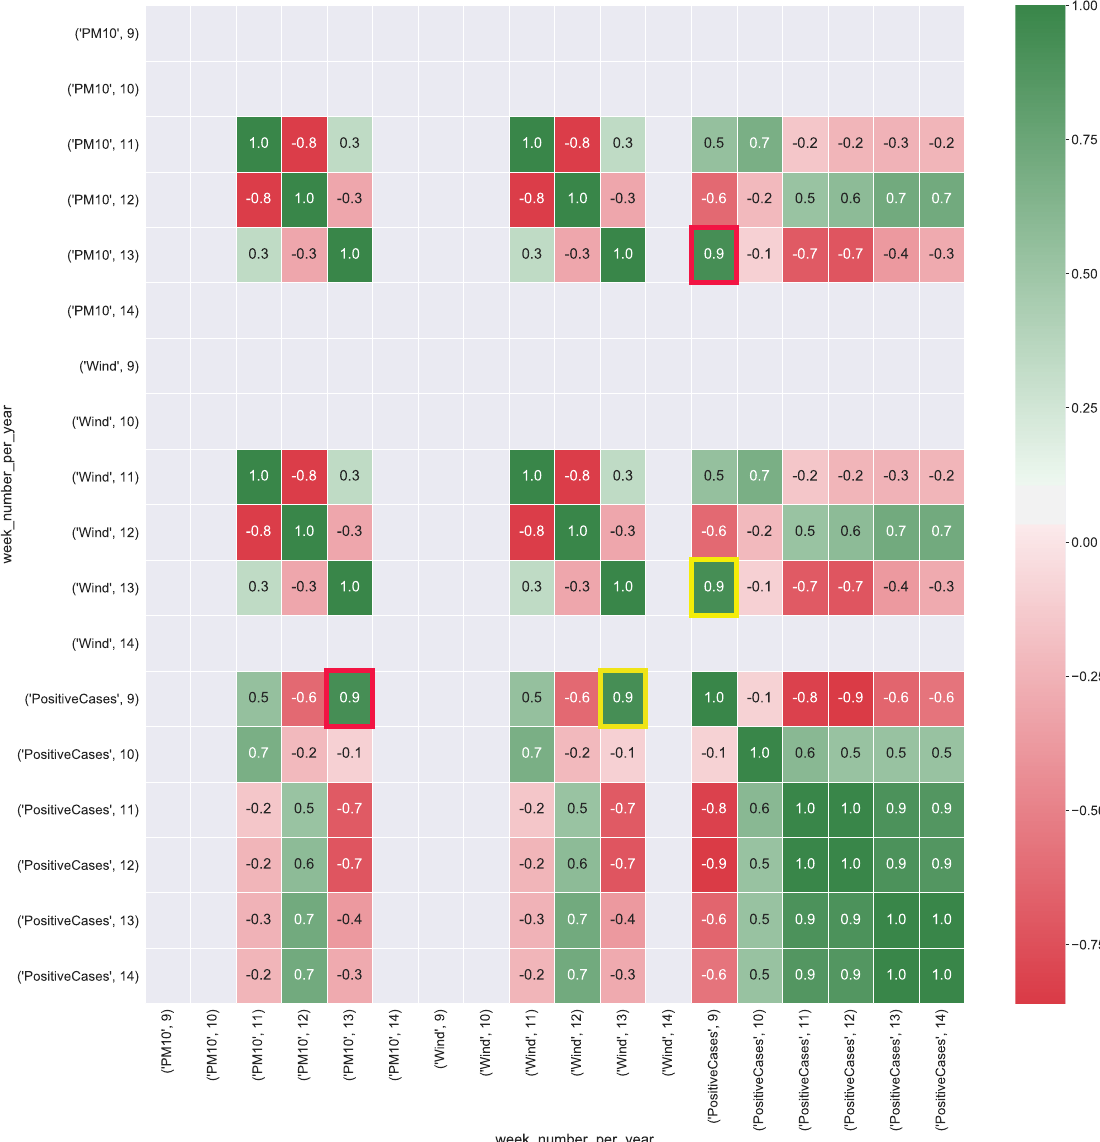
Figure 6. Heatmap representation of the correlation between COVID-19 data aggregate with the air pollution and wind data (km/h) measured in the Puglia region. The heatmap’s labels refer to the attribute’s measured value in a specific week of the year. For instance, ’PM10’, 9 refers to the level of PM10 ( µ g/m 3 ) in the air measured in the 9-th week of the year. In Figure the yellow squares highlight the strong correlation between positive cases and the presence of wind, whereas red squares show the strong correlation between air particulate and the number of positive